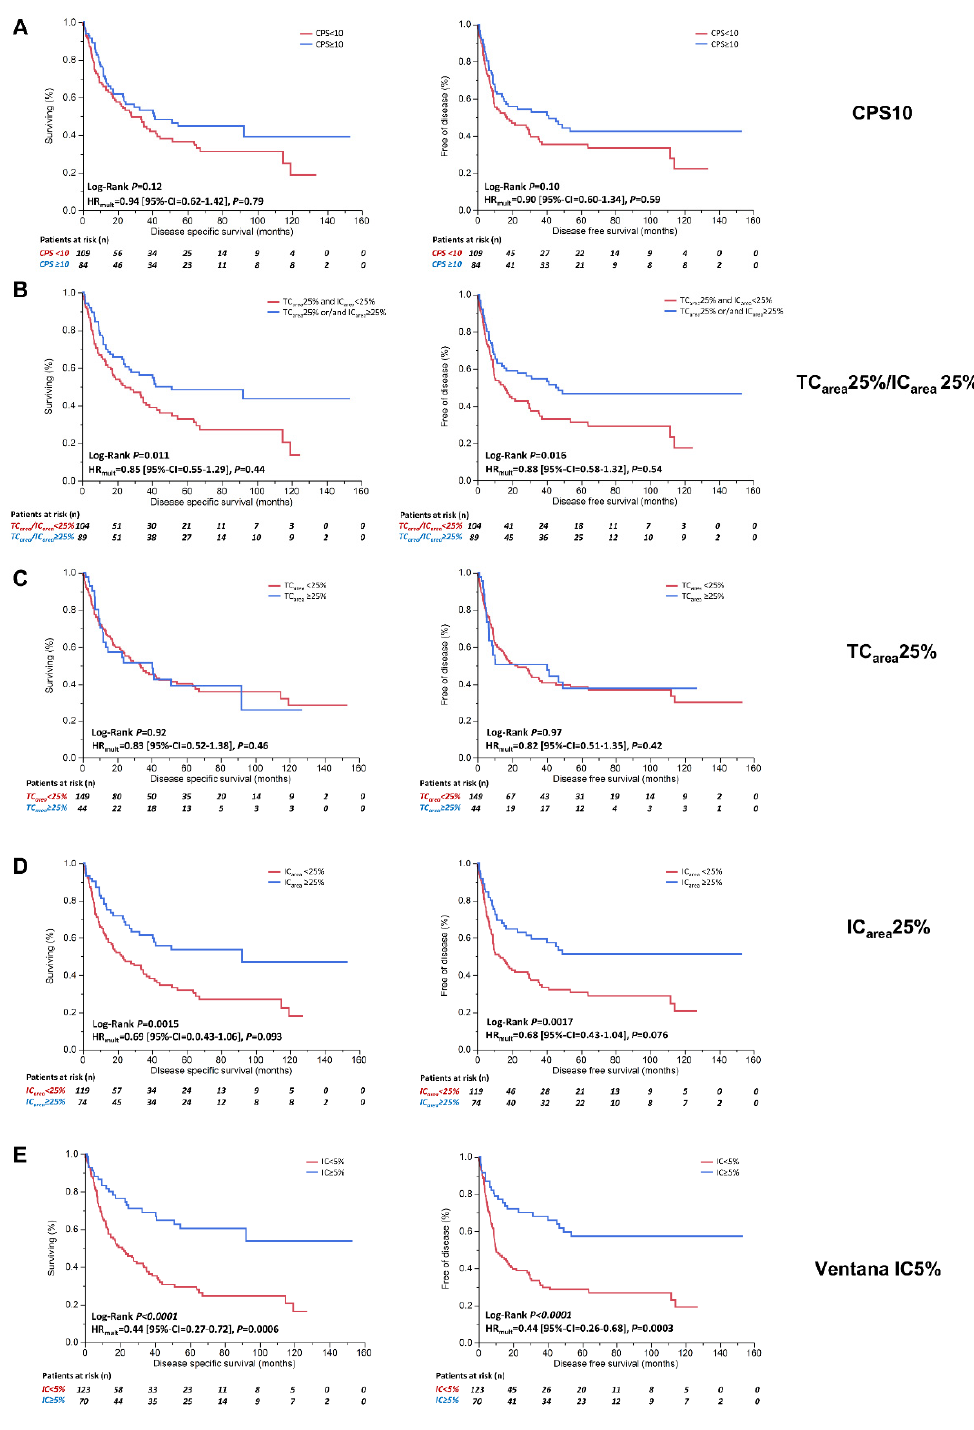
Figure 2. Prognostic impact of different PD-L1 scoring algorithms and cut-offs. Univariable Kaplan–Meier analyses of disease-specific survival (months) and disease-free survival (months) according to ( A ) CPS10, ( B ) TC area 25%/IC area 25%, ( C ) TC area 25% alone, ( D ) IC area 25% alone, and ( E ) Ventana IC5% algorithms. Univariable log-rank p -values and multivariable hazard ratios (HR) derived by Cox regression analyses are depicted below survival curves. Detailed multivariable survival models are summarized in Supplementary Table S3. All multivariable Cox regression analyses exploring the displayed indicator variables were adjusted for pT ‐ Stage, pN ‐ Stage, lymphovascular invasion (L), age, gender, resection margin status, receipt of an adjuvant platinum ‐ containing chemotherapy regimen, and tumor grading (WHO2016 and WHO1973). Patients at risk at various milestones are depicted below survival curves. Abbreviations: CPS = combined positivity score; HR = Hazard Ratio; IC = immune cell(s); TC = tumor cell(s).